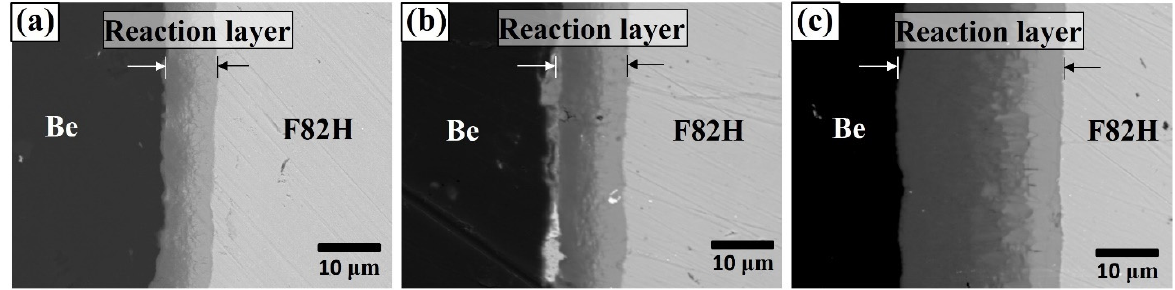
Figure 2. Cross-sectional SEM images of Be–F82H joints sintered at ( a ) 923 K, ( b ) 1023 K, and ( c ) 1123 K for 90 min.